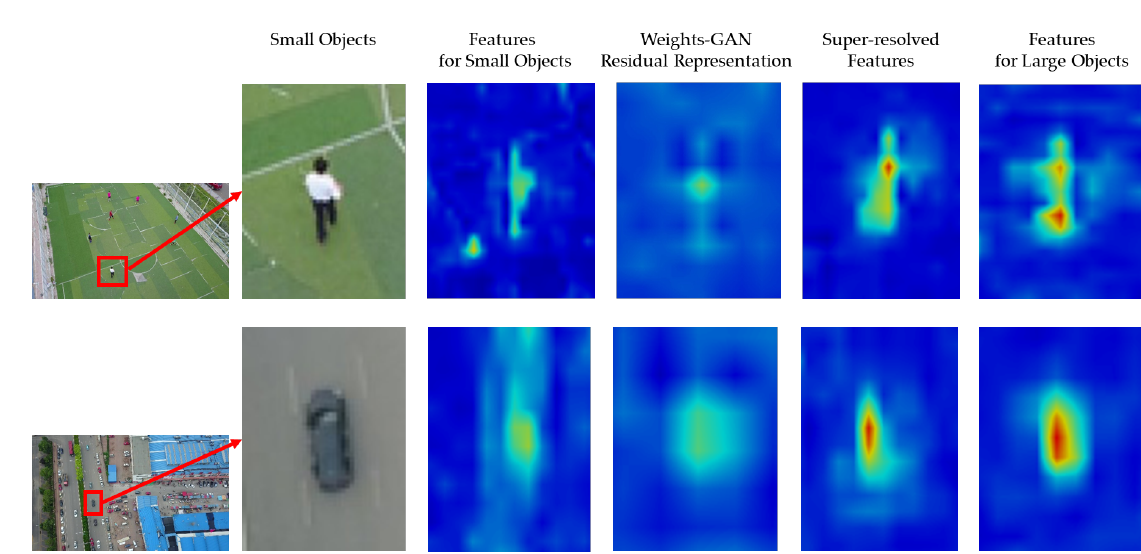
Figure 10. Visualization of the super-resolved features generated by weight-GAN.